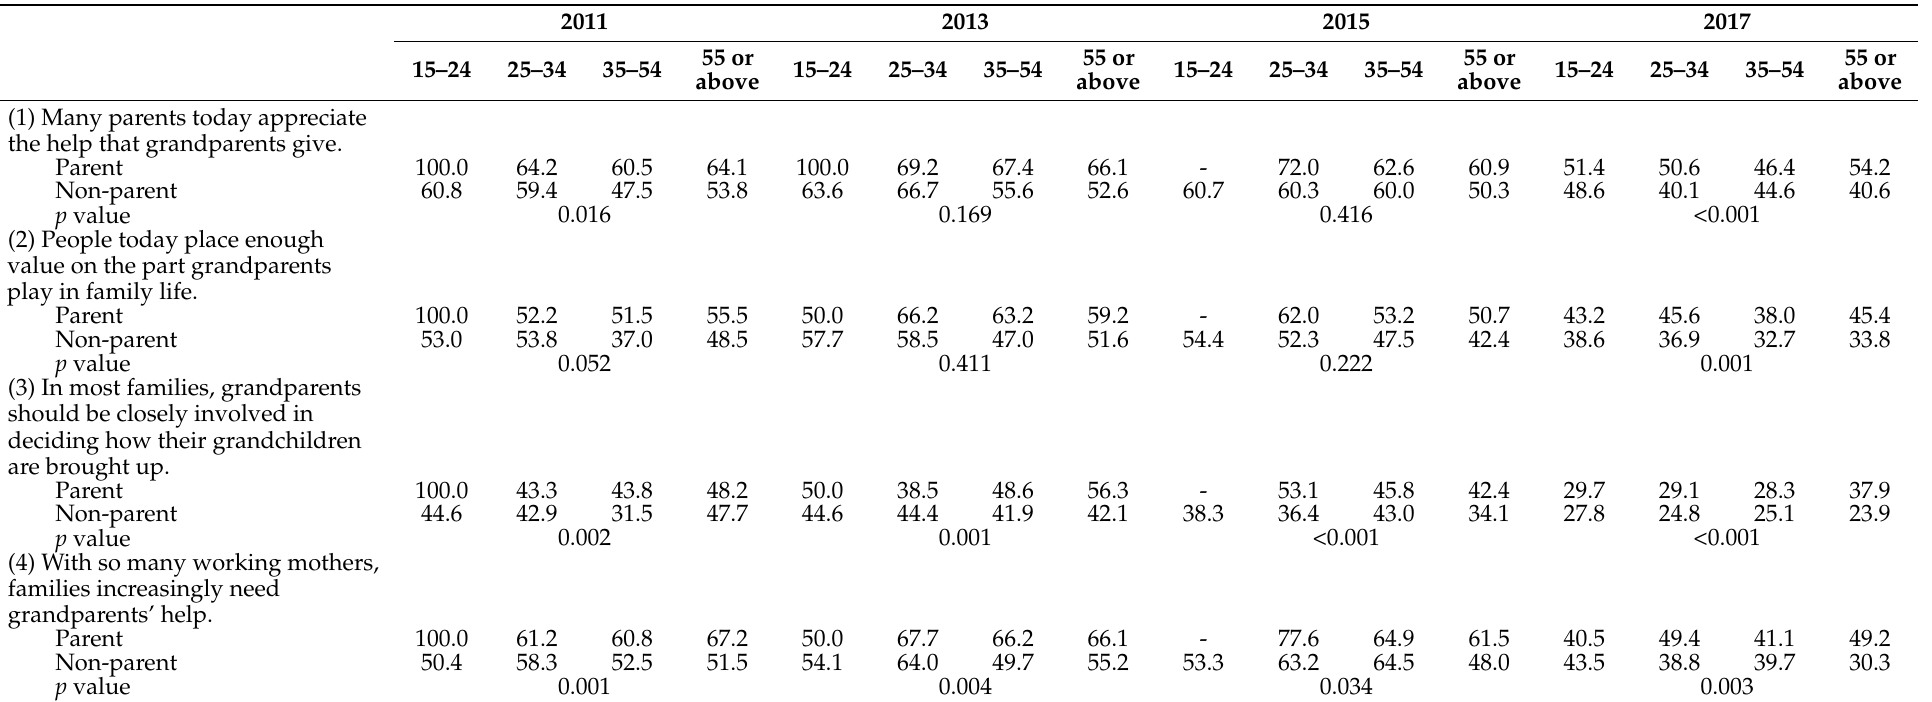
Table 3. Agreement (%) on Attitudes Toward the Involvement of Grandparents by Parental Role and Age